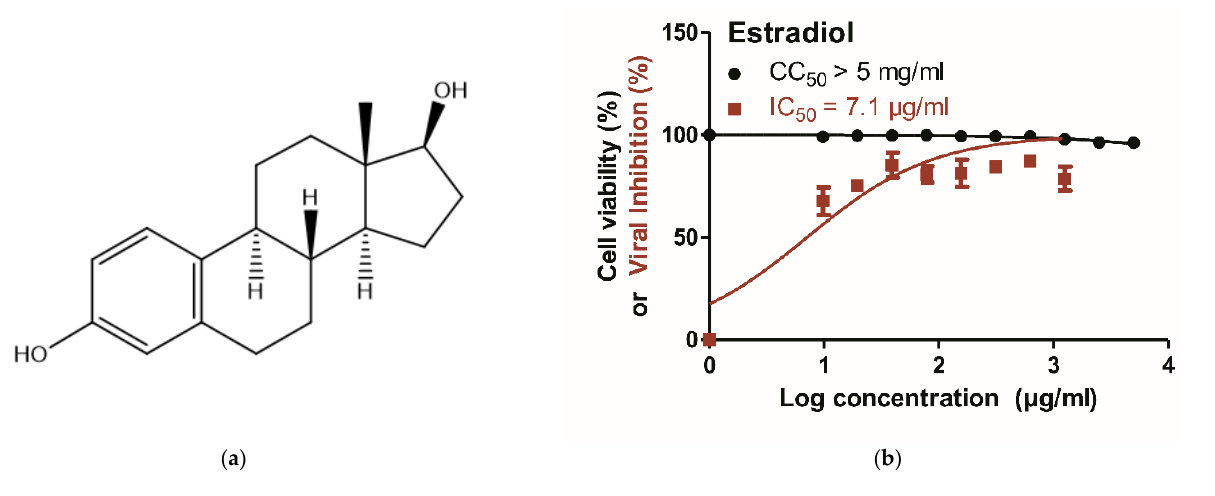
Figure 7. Structural similarity of β -sitosterol with estradiol and potential anti-influenza activity. ( a ) Chemical structure of the potent human estrogen form; namely estradiol; ( b ) the cytotoxicity of estradiol as expressed in CC 50 and the antiviral activity against A/H1N1 as expressed as an IC 50 value. GraphPad Prism 5.01 software was used to analyze the nonlinear regression, while the CC 50 and IC 50 were determined by plotting log inhibitor against normalized response (variable slope).